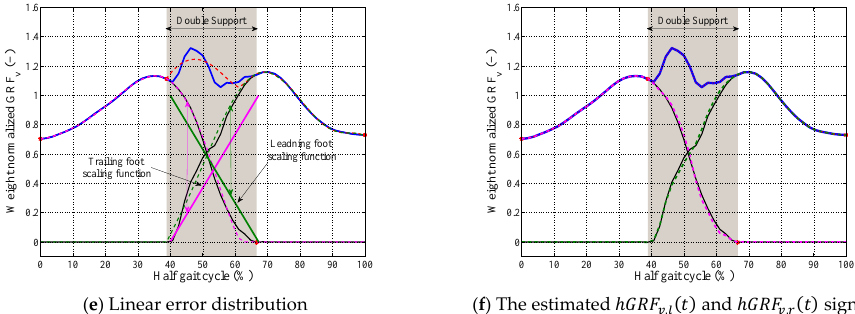
Figure 5. TPM procedure for estimation of hGRF v ( t ) B. Anterior-posterior direction